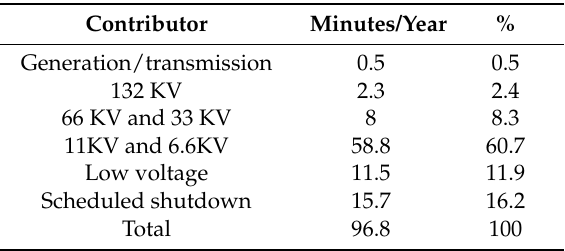
Table 7. Typical outage rate for a consumer